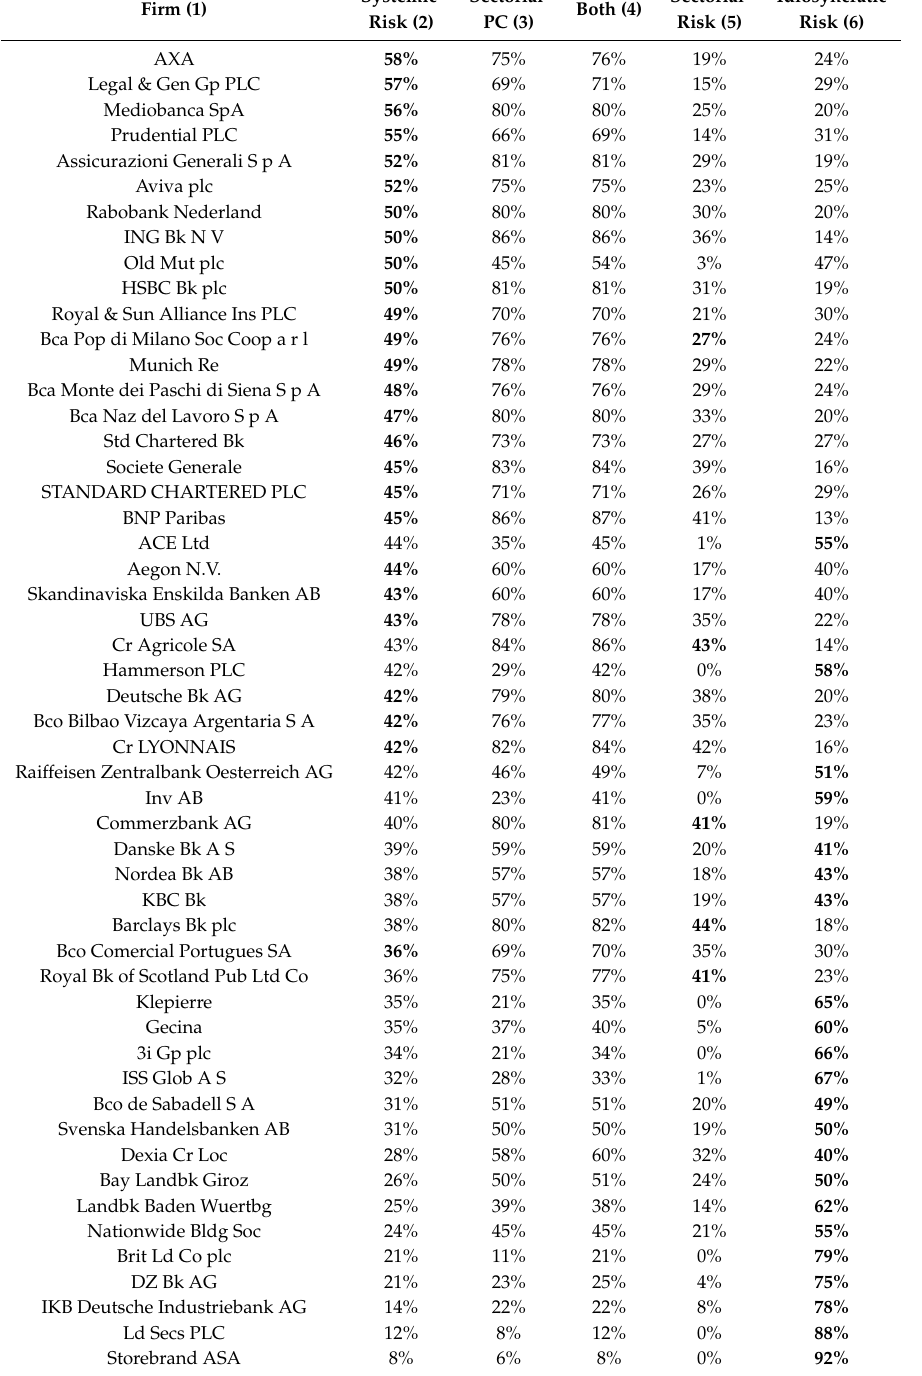
Table 10. Credit risk decomposition for the European financial